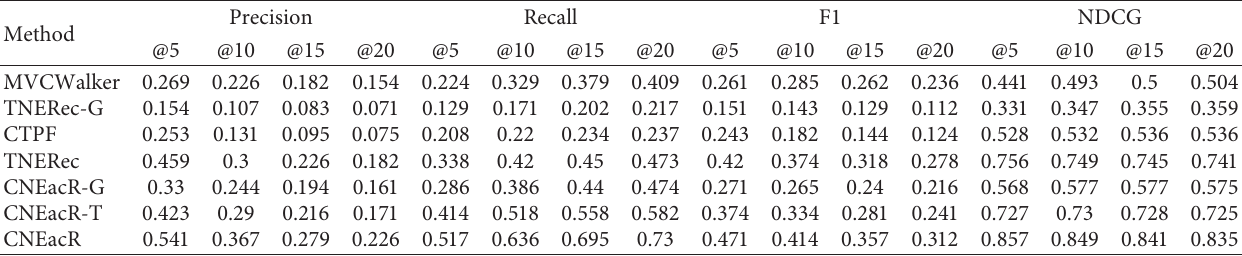
Table 3: Performance on different evaluation criteria in PRB.